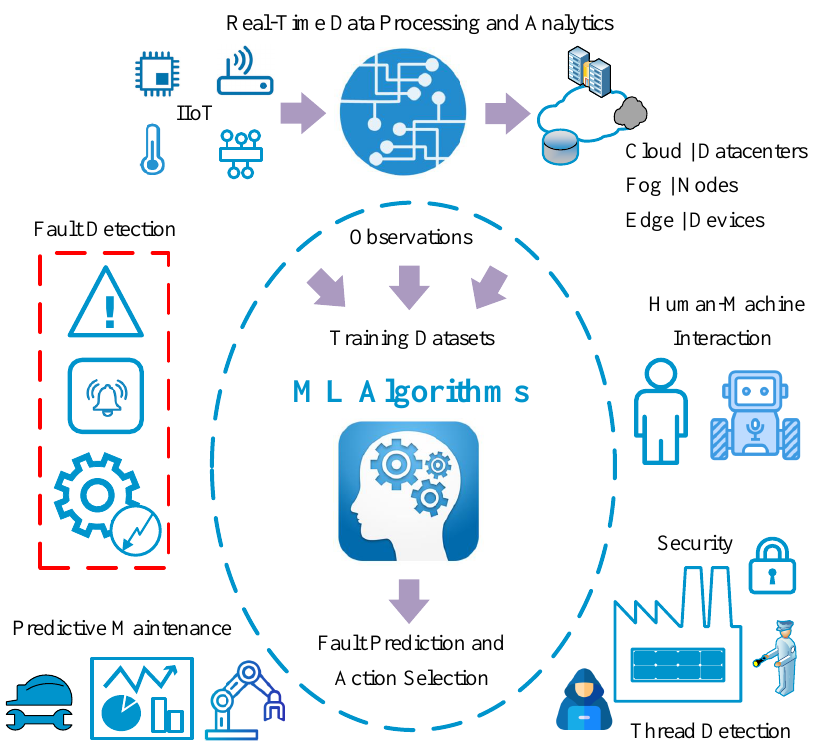
Figure 2. Applications of AI/ML in Industry 4.0 fault detection, prediction and